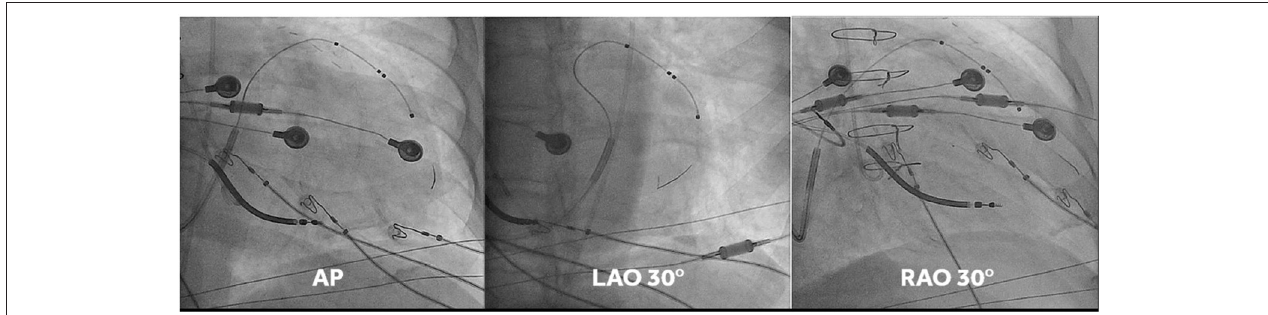
FIGURE 1 | Fluoro-images at AP, LAO 30 ◦ and RAO 30 ◦ displaying position of the different CRT leads. Note that in this case the vision wire administered through the lumen of the quadripolar was used to obtain true apical position. MPP was delivered on the vision wire, and on the distal and most proximal electrodes of the short bipole of the quadripolar